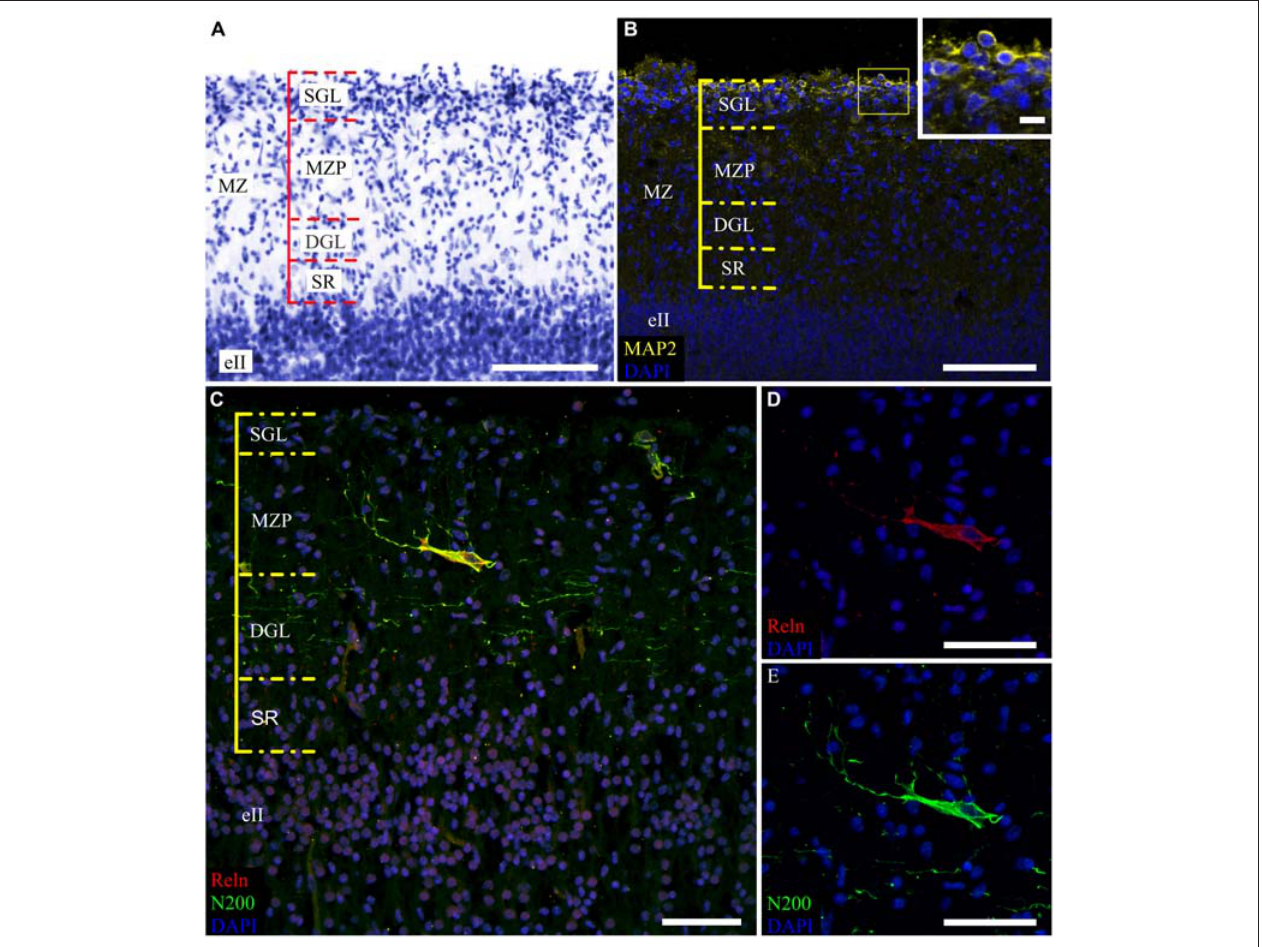
FIGURE 2 | Cytoarchitectonics and features of the MZ neurons in the fetal superior temporal gyrus at GW 26. (A) Microphotograph of Nissl-stained paraffin section. Note the MZ cytoarchitectonics. (B) Photomicrograph of paraffin section stained for MAP2, SGL MAP2-positive cells is shown in the insert. (C) C–R cell of the same area double stained for Reelin (C,D) and neurofilament heavy chain protein (N200) (C,E) . Note the N200-positive plexus. Scale bars: (A–C) 100 µ m; (D,E) 50 µ m, insert in (B) 10 µ